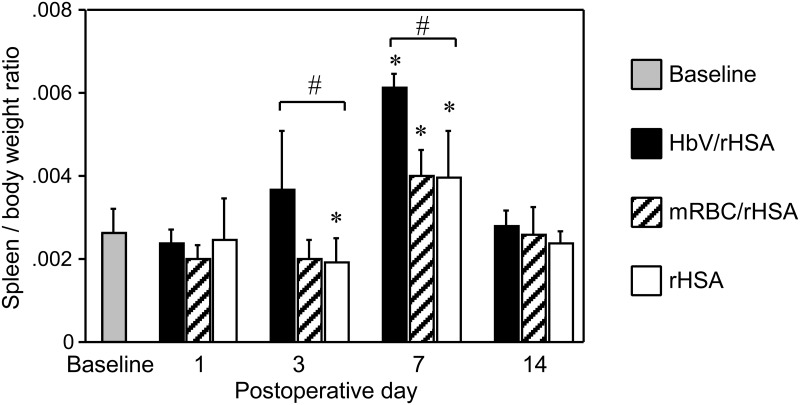
Changes in spleen/body weight ratio between the baseline period and the 14th postoperative day (POD) in the indicated study groups.Values are shown as the mean ± SD. n = 10 in each group. *P < 0.05 versus baseline (Student’s t-test), #P < 0.05 versus the rHSA group (Dunnett’s test).